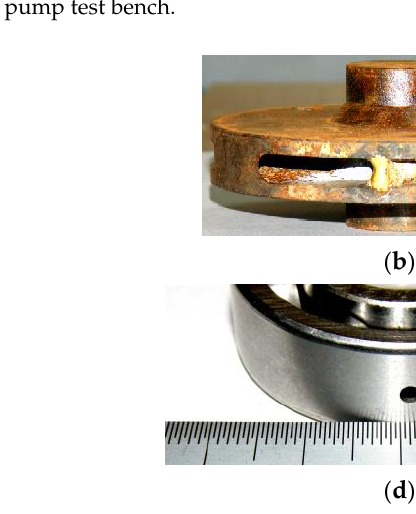
Figure 11. Photographs of the defective component under study: ( a ) Broken impeller (BI); ( b ) clogged impeller (CI); ( c ) bearing with inner race defect (IR); ( d ) bearing with outer race defect (OR).